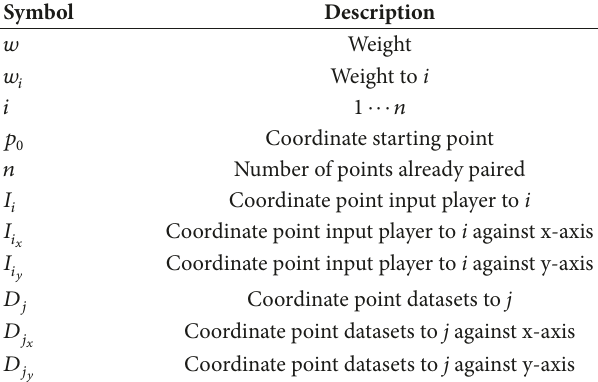
Table 10: Description of Formula Greedy Cloud Distance. Symbol Description